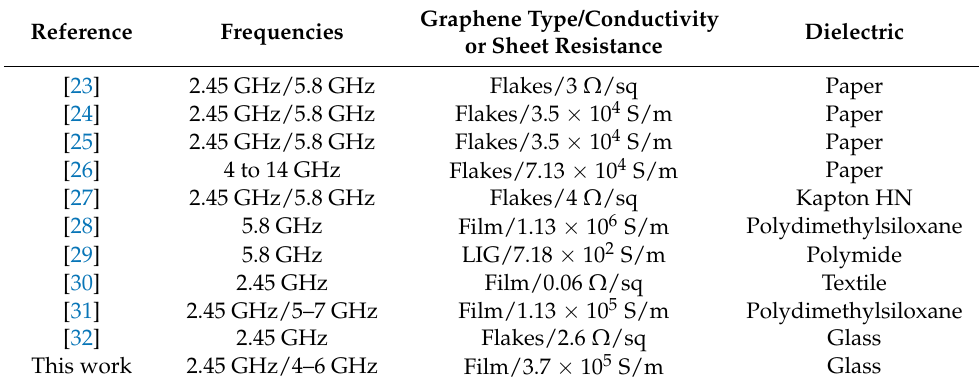
Table 1. Comparison between reporter